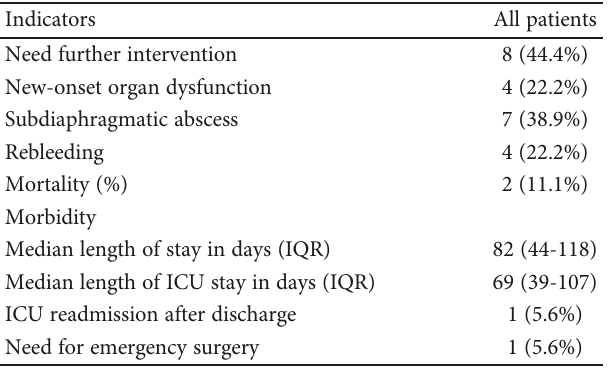
Table 2: Clinical outcomes of patients with splenic abscess after splenic arterial